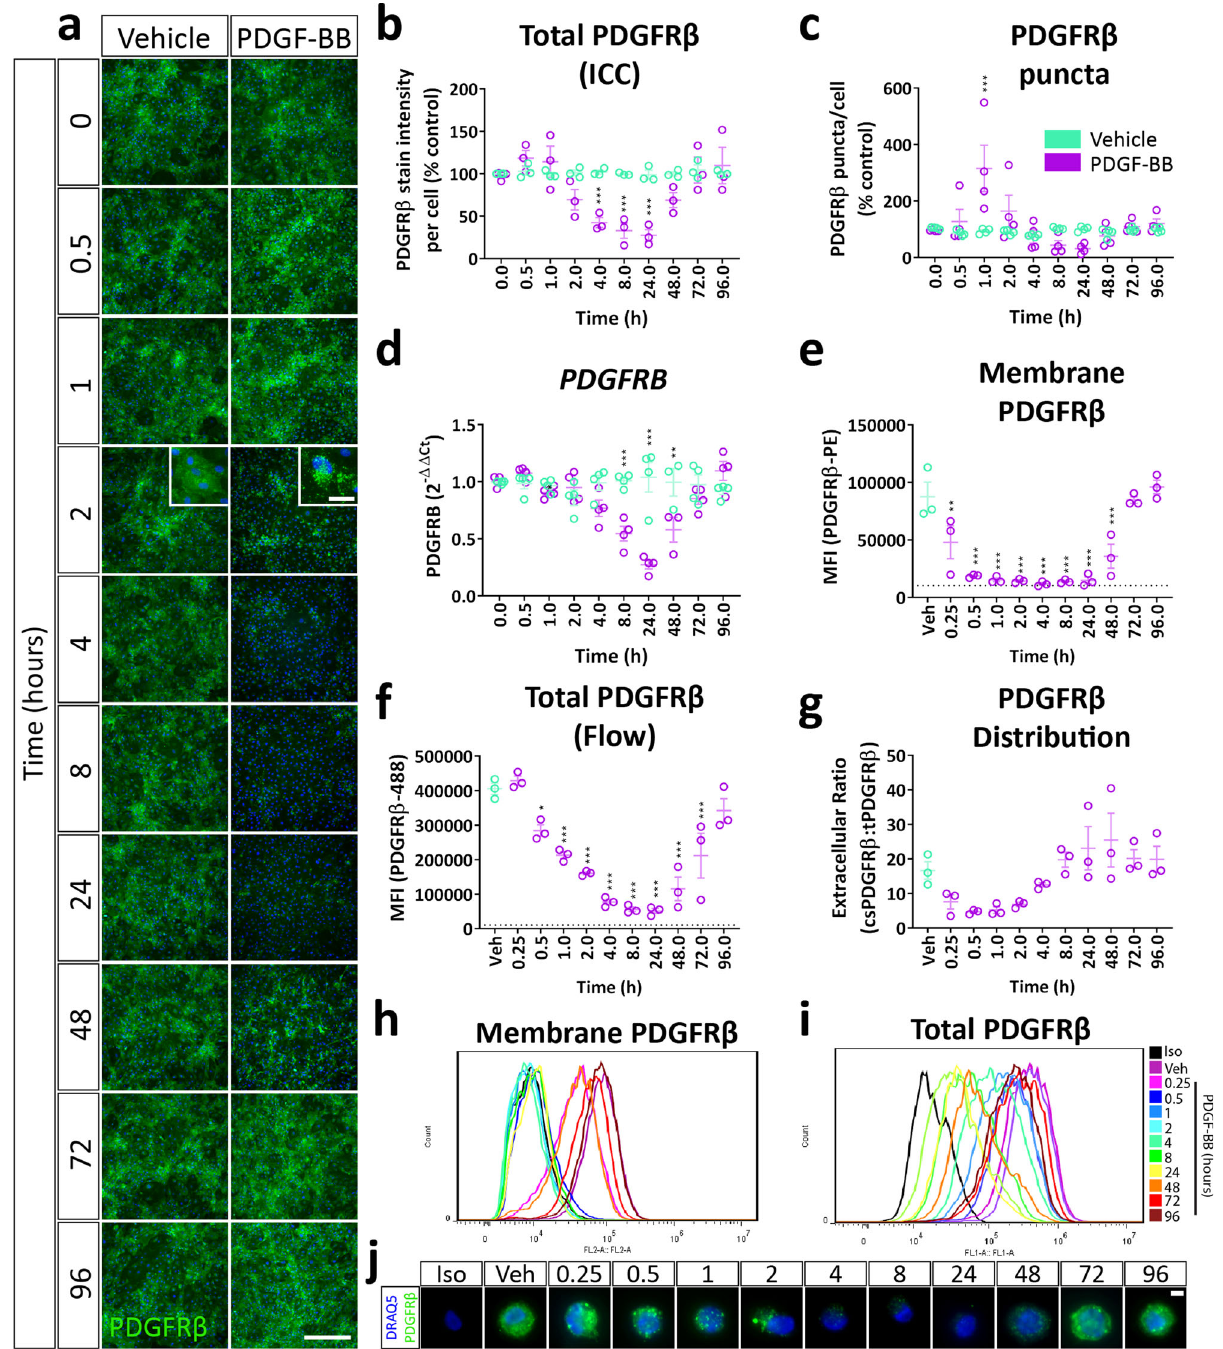
Fig. 3 PDGF-BB treatment causes a transient loss of PDGFR β expression due to internalisation in pericytes. Brain pericytes were treated with PDGF-BB (10ng/mL) or vehicle for the speci fi ed time, then stained for cell-surface PDGFR β for fl ow cytometry, fi xed and stained for total PDGFR β expression or RNA extracted for qPCR. a Representative images and quanti fi cation of b total PDGFR β immunostaining and c PDGFR β puncta formation in pericytes treated with vehicle or PDGF-BB. Scale bar = 500 μ m, inset = 25 μ m. n = 3 – 4, two-way ANOVA. d Gene expression of PDGFRB in pericytes incubated for different lengths of time with PDGF-BB. Expression of e cell surface and f total PDGFR β and g the distribution of PDGFR β determined by fl ow cytometry. n = 3, one-way ANOVA. Representative histograms of h cell surface and i total PDGFR β and j representative images of total PDGFR β expression in cells analysed by fl ow cytometry. Scale bar = 5 μ m. * p <0.05, ** p <0.01, *** p <0.001 vs vehicle control, # p <0.05, ## p <0.01, ### p <0.001 vs